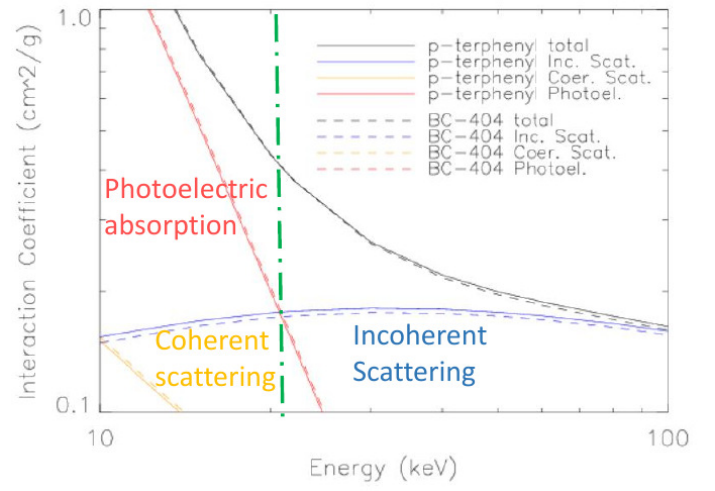
Figure 8. Mass attenuation coefficients of photoelectric absorption, coherent scattering and incoherent scattering for typical plastic scintillator materials (BC-404 and p-terphenyl) which the scatterers are made